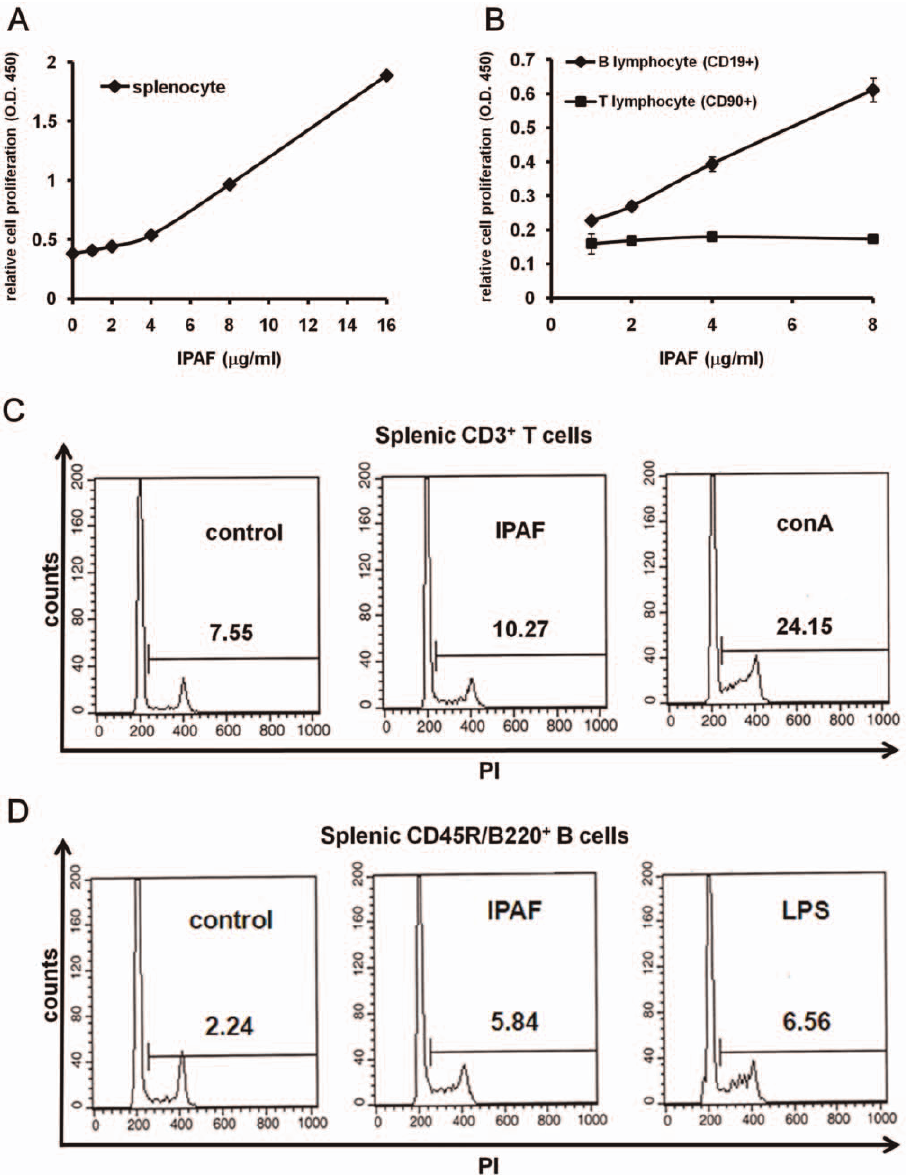
Figure 3. IPAF stimulated the cell proliferation of mouse splenic B lymphocytes. (A) Splenocytes harvested from BALB/c (5 6 10 5 cells per well) were treated with IPAF of indicated concentrations for 72 hours, cell proliferation was determined by BrdU assay. (B) MACS purified splenic T (CD90 + ) cells and B (CD19 + ) cells from BALB/c were treated with IPAF of indicated concentrations for 72 hours, cell proliferation was determined by BrdU assay. (C) Splenocytes harvested from BALB/c were treated with medium (left), 8 m g/mL IPAF (middle), 5 m g/mL conA (right) for 72 hours. Cells were harvested and stained with PE-labeled anti-mouse CD3 and PI for flow cytometry analysis. T cells were gated based on CD3 fluorescence, and proliferating cells were determined based on PI fluorescence intensity. Data are presented as percentage of proliferating cells in total cells. (D) Splenocytes harvested from BALB/c were treated with medium (left), 8 m g/ml IPAF (middle) and 5 m g/mL LPS (right) for 72 hours. Cells were harvested and stained with FITC-labeled anti-mouse CD45R/B220 and PI for flow cytometry analysis. B cells were gated based on CD45R/B220 fluorescence, and proliferating cells were determined based on PI fluorescence intensity. Data are presented as percentage of proliferating cells in total